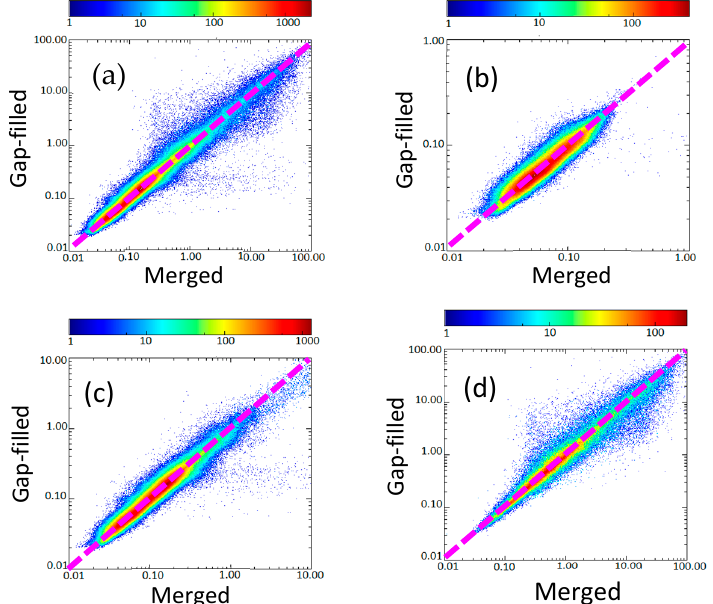
Figure 3. Density scatter plots of gap-filled versus merged Chl-a values for ( a ) all selected validation pixels, ( b ) oligotrophic waters, ( c ) deep waters, and ( d ) coastal and inland waters on 21 June 2018.